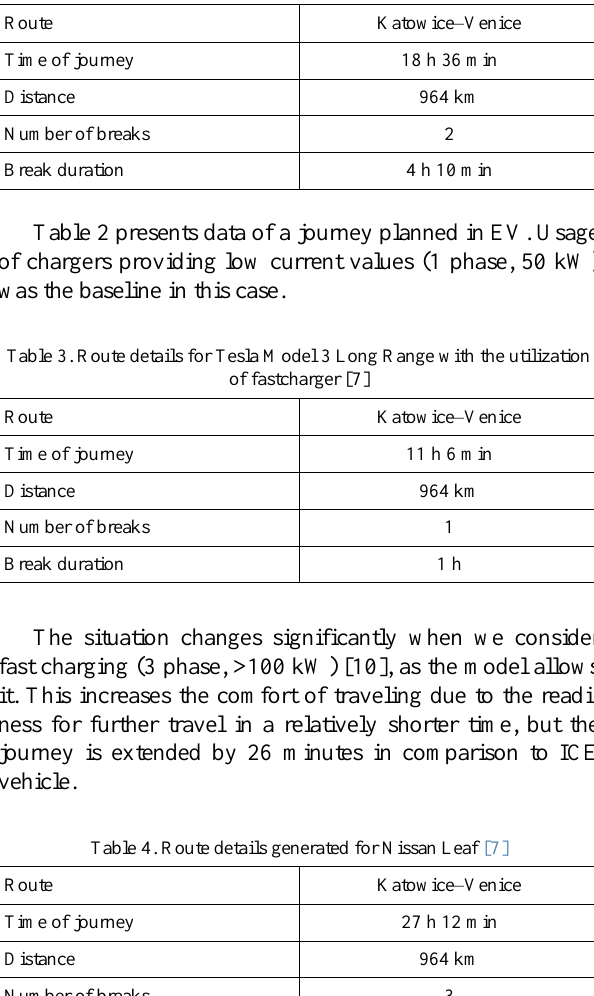
Table 2. Route details generated for Tesla Model 3 Long Range [7]